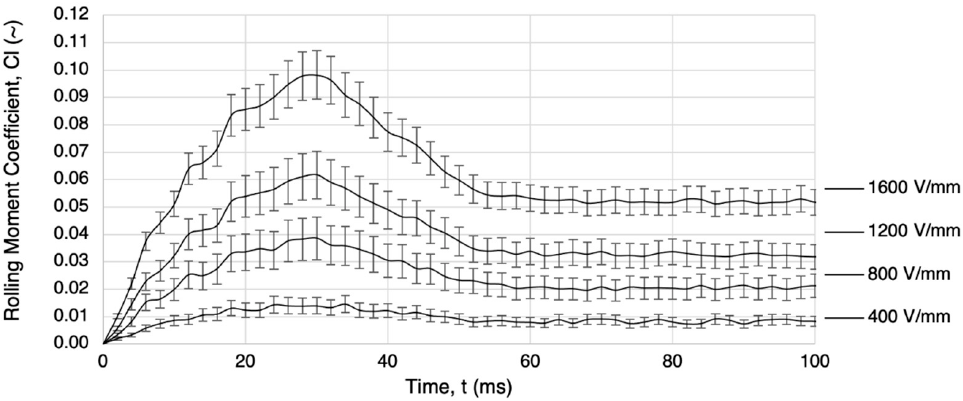
Figure 14. Rolling moment coefficient about the wing root, 40 ft/s (12.2 m/s), Rn = 64,000.